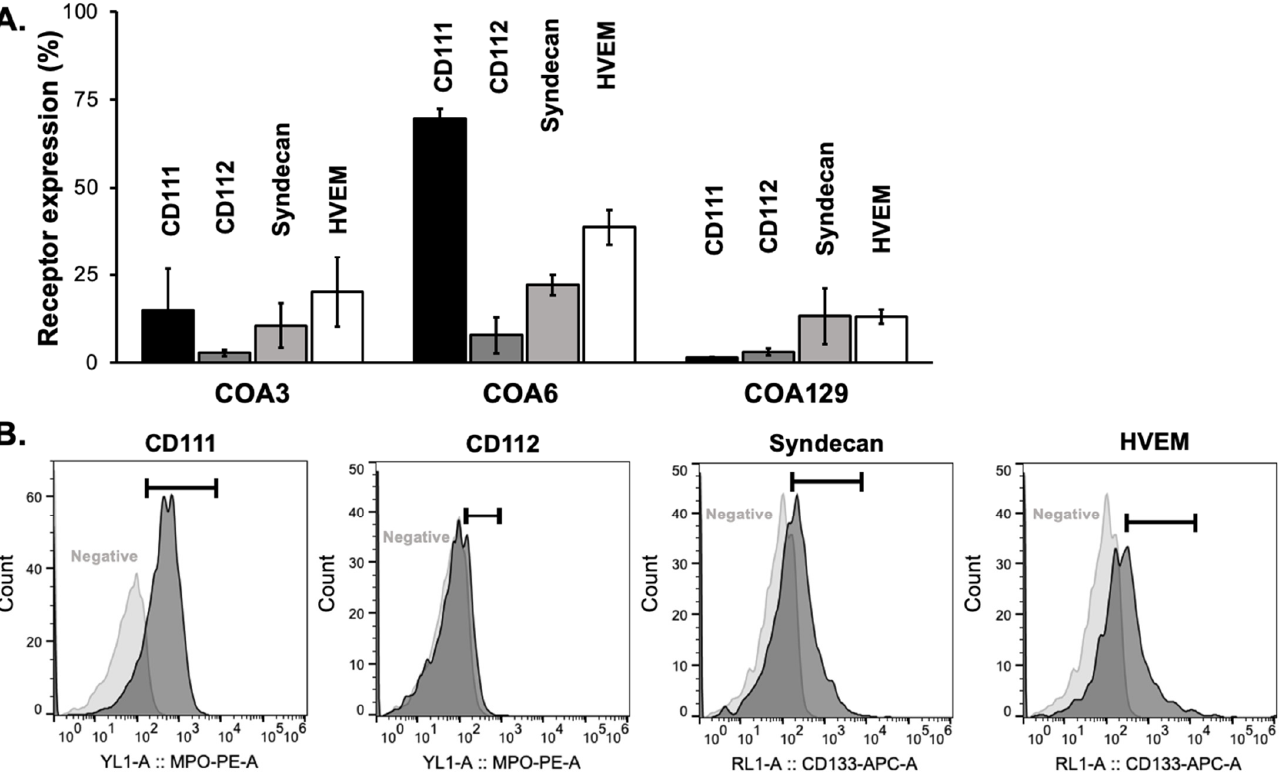
Figure 1. Neuroblastoma PDXs express viral entry receptors. ( A ) Flow cytometry was used to detect the cell surface expression of the four main HSV receptors: CD111, CD112, syndecan, and HVEM in COA3, COA6, and COA129 human neuroblastoma PDX cells. All PDXs expressed all four receptors. ( B ) Representative histograms of CD111, CD112, syndecan, and HVEM cell surface expression and negative controls of COA6 are shown. Data reported as mean ± SEM and represent at least three biologic replicates.